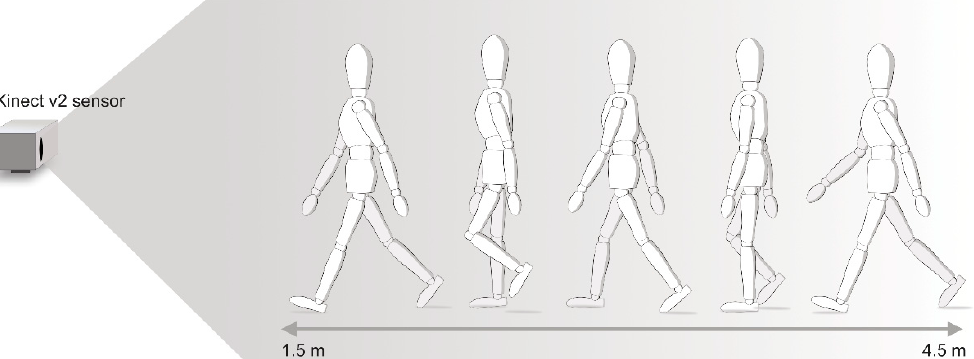
Figure 1. Technical set-up of the Motognosis Labs motion analysis system with a single Microsoft Kinect v2 sensor with exemplary sketch of a gait task. The illustration was included by courtesy of Motognosis GmbH.